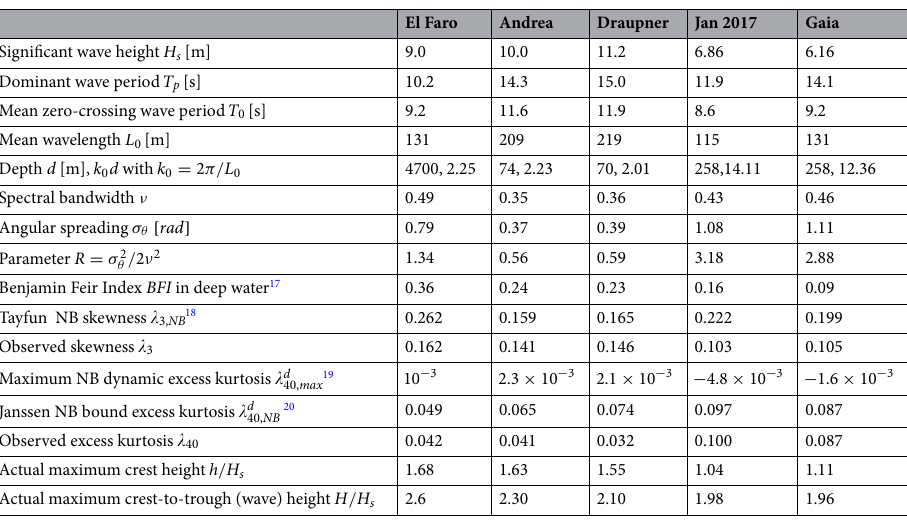
Table 1. Wave parameters and various statistics of Jan 2017 and Gaia at the storm peak in comparison to the El Faro, Andrea and Draupner rogue sea states 12 . We refer to the “Methods” section for the definitions of wave